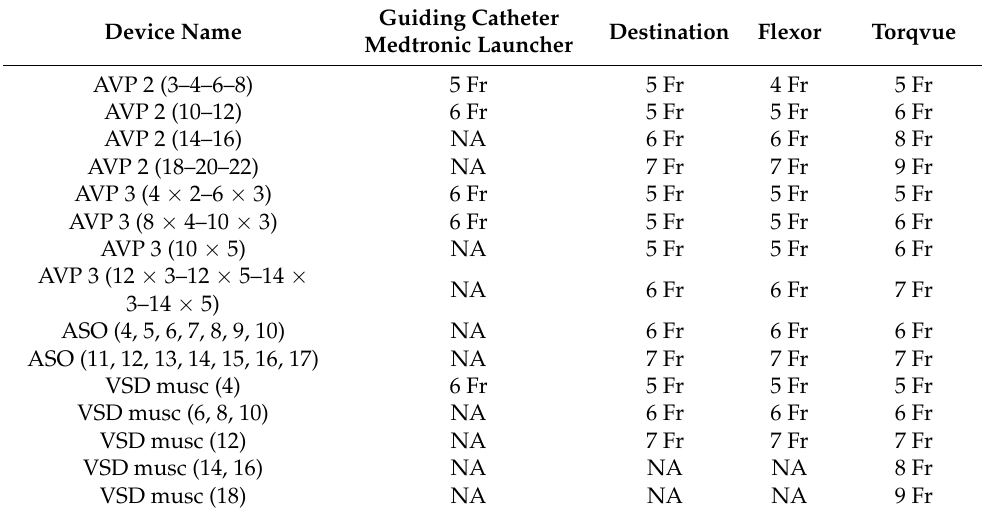
Table 7. The list of Abbott devices used in the 3 registries with their compatibility with various delivery sheaths. AVP 4 were delivered through a 4-Fr braided diagnostic catheter with a 0.038-inch inner